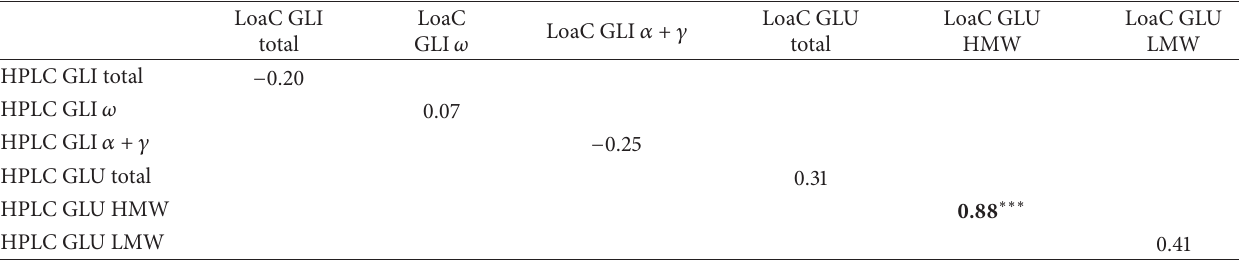
Table 5: Correlation coefficients between number of bands/peaks of gliadin and glutenin subunits determined by LoaC and RP-HPLC methods.